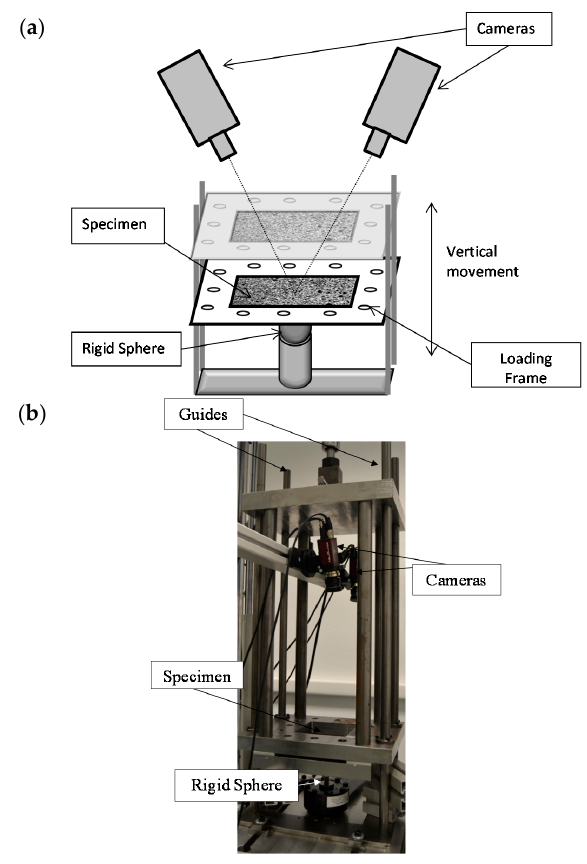
Figure 8. Experimental setup adopted. ( a ) Schematic illustration showing the setup to perform the test; ( b ) setup adopted for the experimental methodology proposed.